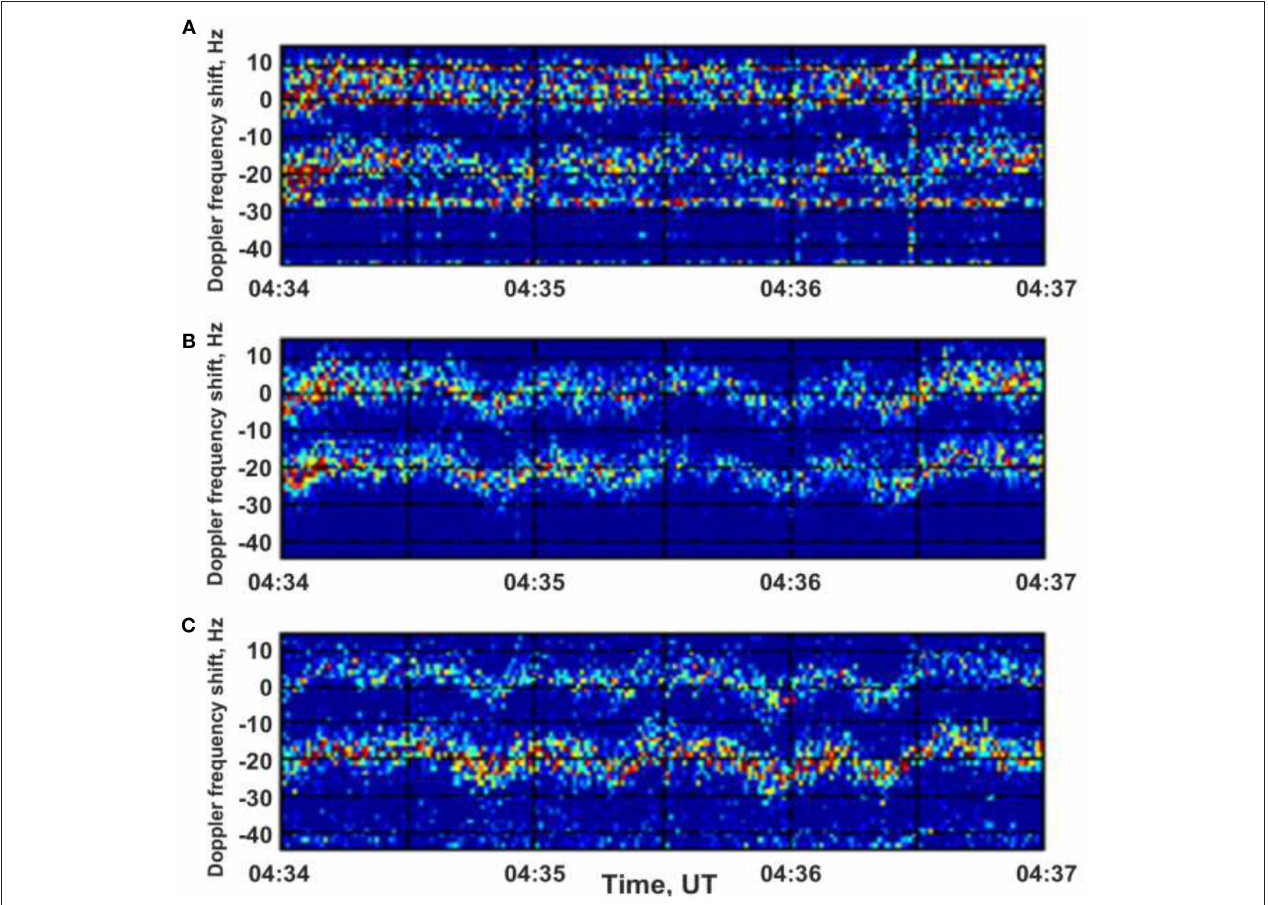
FIGURE 3 | Dynamic spectra for the scattered components of the signal received at the UAS (A) , RAO (B) , and StP (C) on 29 October 2002 from 04:34 to 04:37